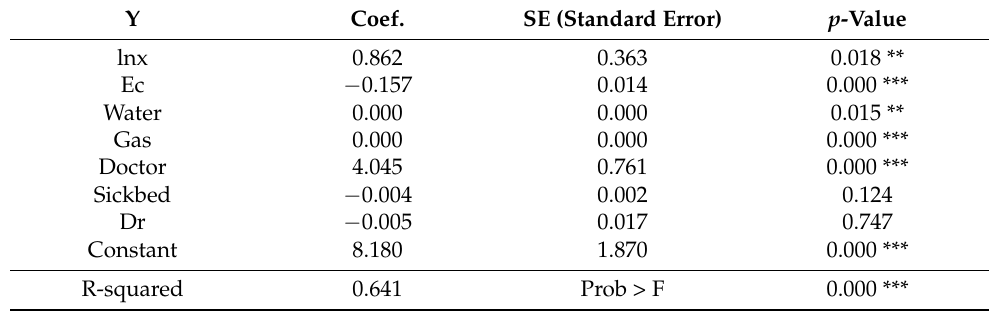
Table 2. Regression results of panel